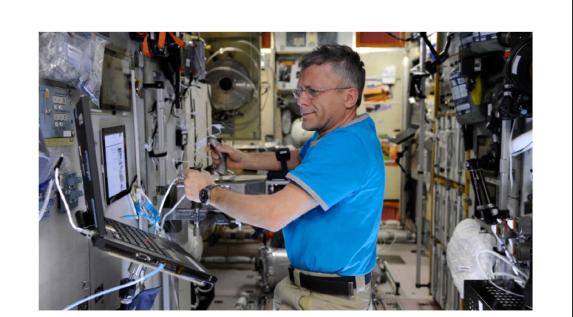
FIGURE3 Experimental setup on board the International Space Station. Cosmonaut during the system